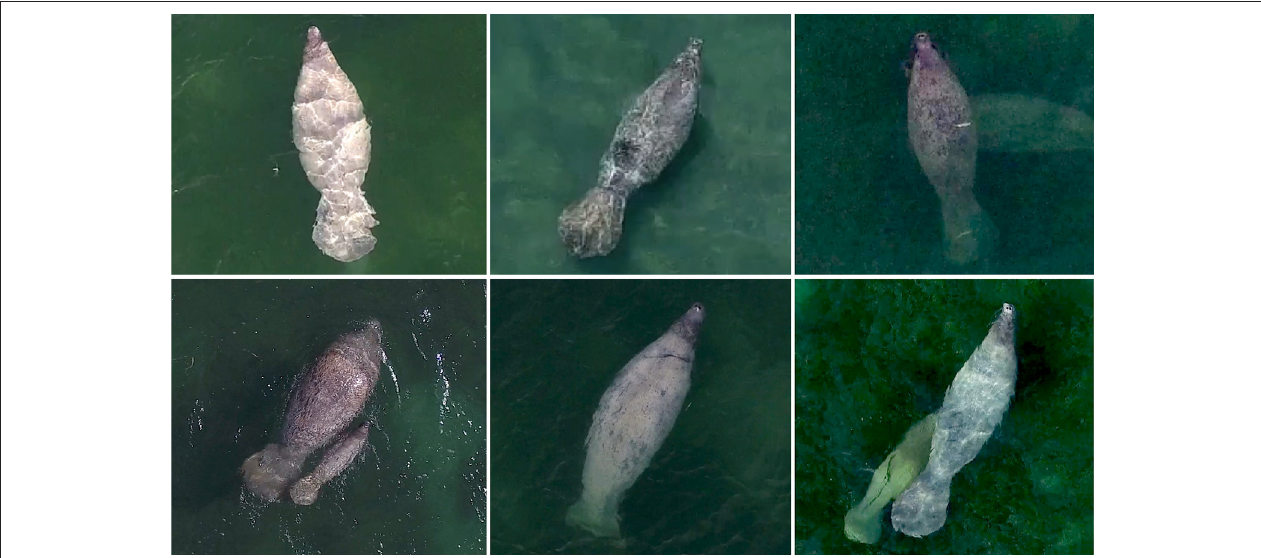
FIGURE 2 | Aerial images of Antillean manatees illustrating identifying features used for photo-identification.